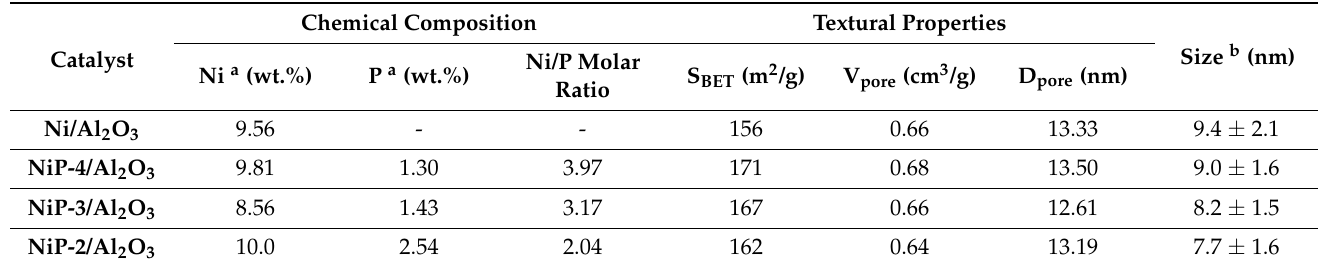
Table 1. Chemical composition, textural properties, and particle size distribution of reduced Al 2 O 3 supported catalysts.